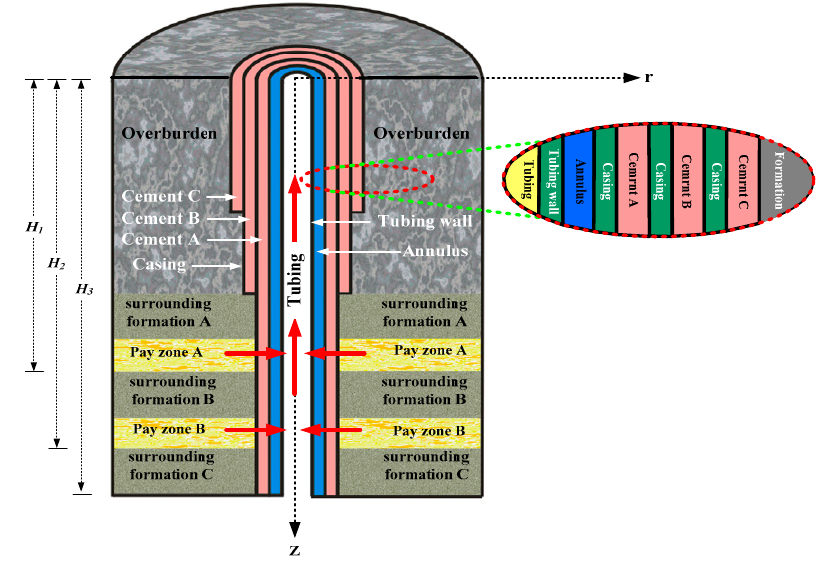
Figure 3. Schematic of the downhole temperature model.